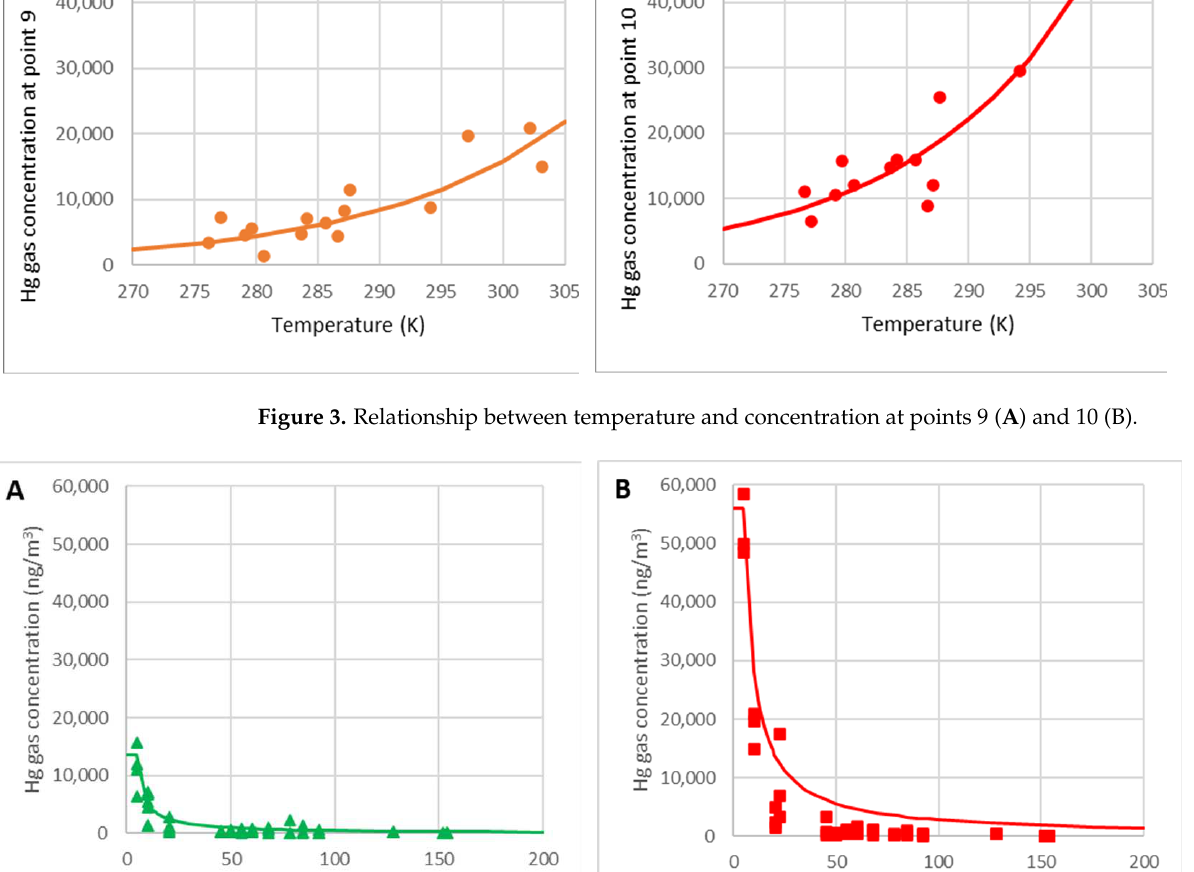
Figure 4. Variation in the concentration with the distance from the focus for T= 283 K ( A ) and T= 303 ( B ). Therefore, the concentration varies with the distance from the focus of the contamina- tion to the measuring point according to the following empirically determined equation: